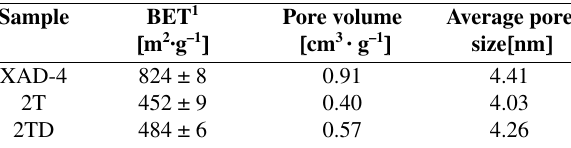
Table 3. Basic parameters of the porous structure calculated for the XAD-4 matrix and the resins 2T and 2TD. Sample BET